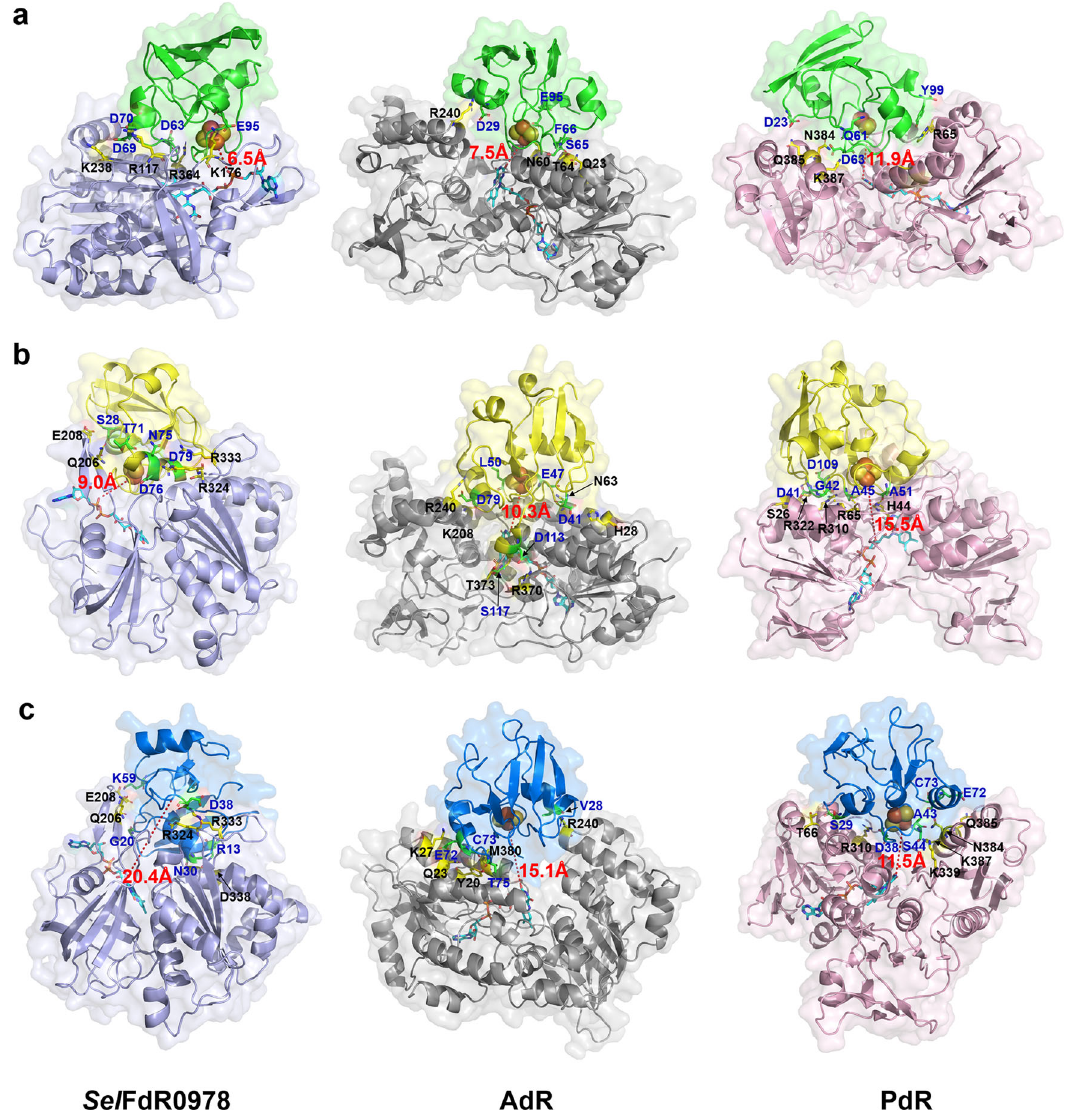
Fig. 6 Fdx-FdR docking models. Docking models of three FdRs in complex with Sel Fdx1499 ( a ), Adx ( b ), and Pdx ( c ). The structures of FdR-Fdx complexes are shown as cartoon with different colors. The key interacting residues on FdR-Fdx interfaces are shown as sticks in yellow and green, respectively. FAD is shown as sticks in cyan. The Fe 2 S 2 cluster is shown as spheres. The shortest FAD-Fe 2 S 2 distances (Å) are indicated by dashed red